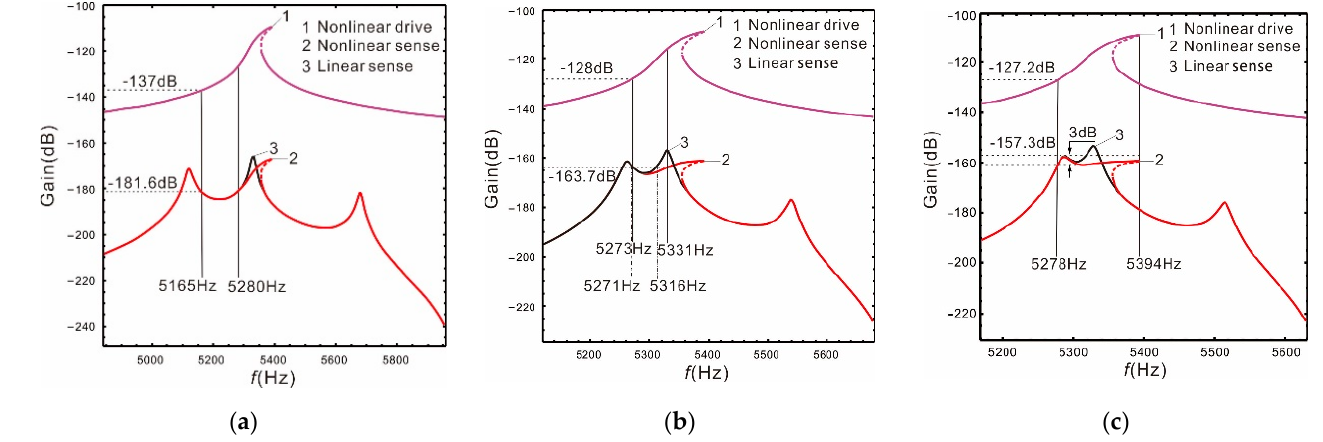
Figure 6. Nonlinear case: the resonant frequency of the drive mode close to the low-order resonant frequency of the sense mode: ( a ) ∆ = 560 Hz ; ( b ) ∆ = 280 Hz ; ( c ) ∆ = 230 Hz .